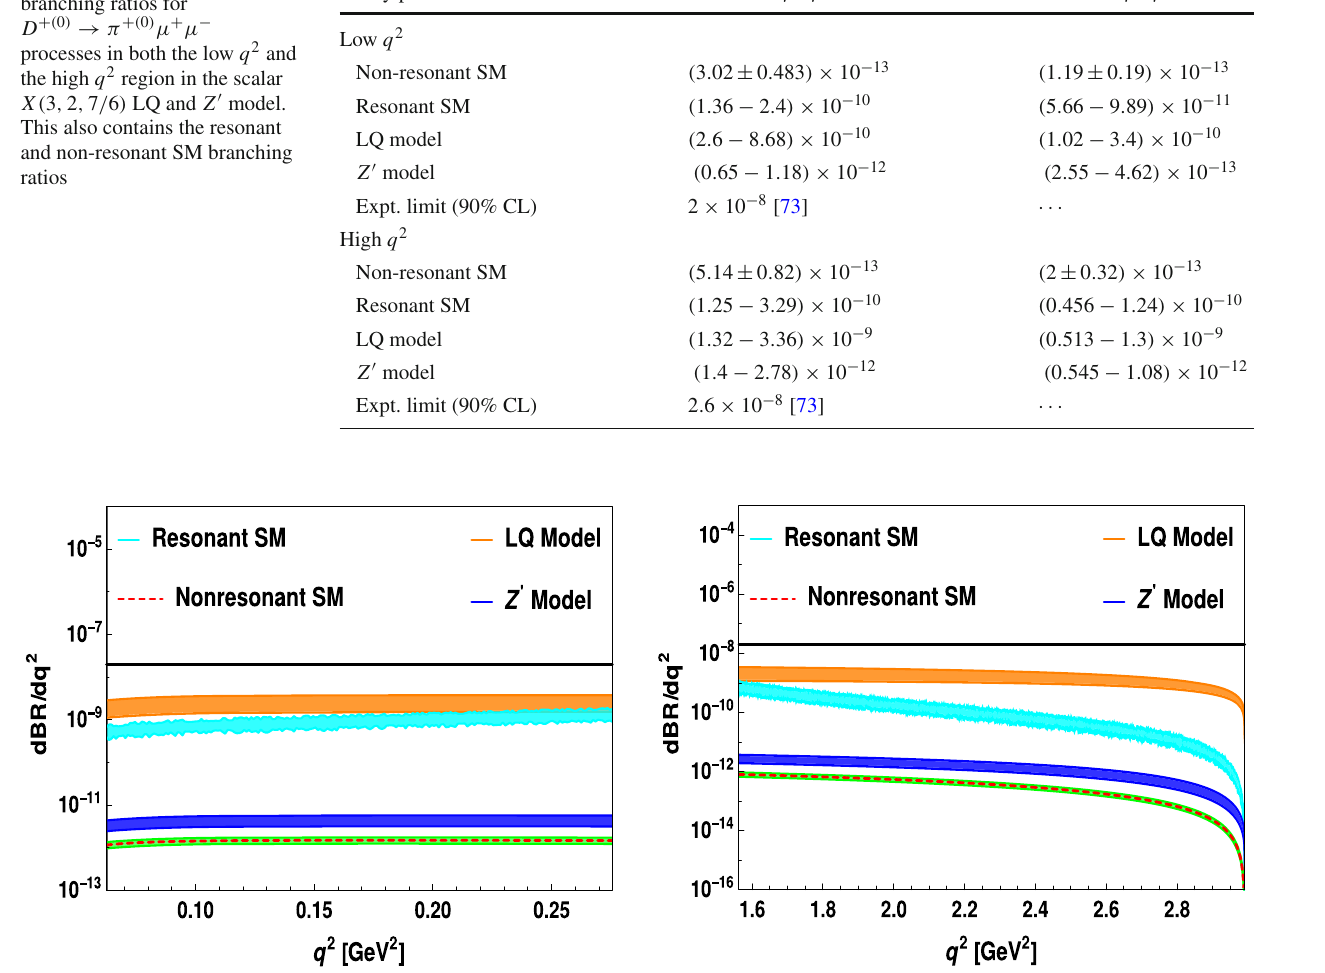
Fig. 3 The variation of branching ratio of D + → π + μ + μ − with respect to low q 2 ( left panel ) and high q 2 ( right panel ). The orange bands represent the contributions from the scalar leptoquark, the blue bands are due to the Z (cid:2) contributions, the red dashed lines are for the